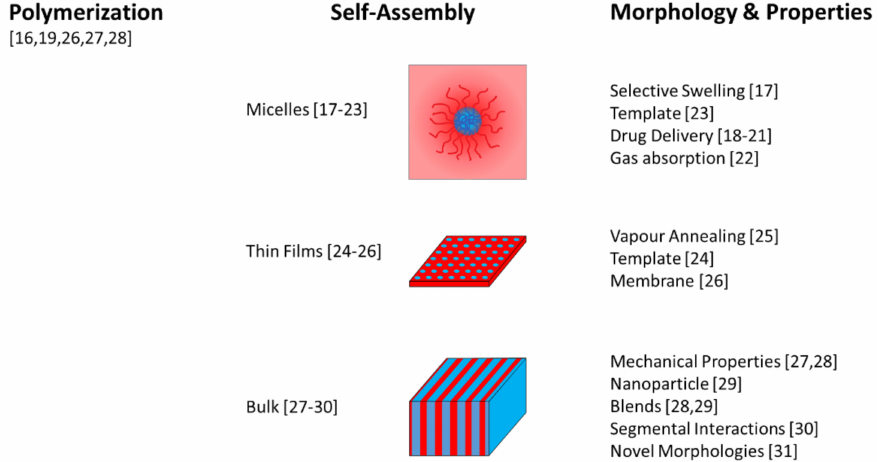
Figure 1. Overview of the topics covered by the manuscripts (indicated by the reference numbers) of this Special